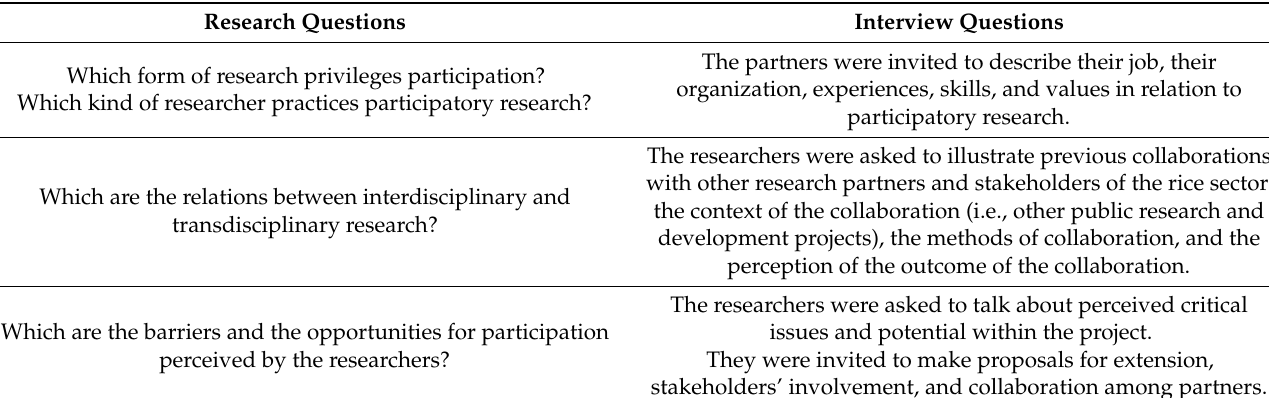
Table 1. Interview guide.